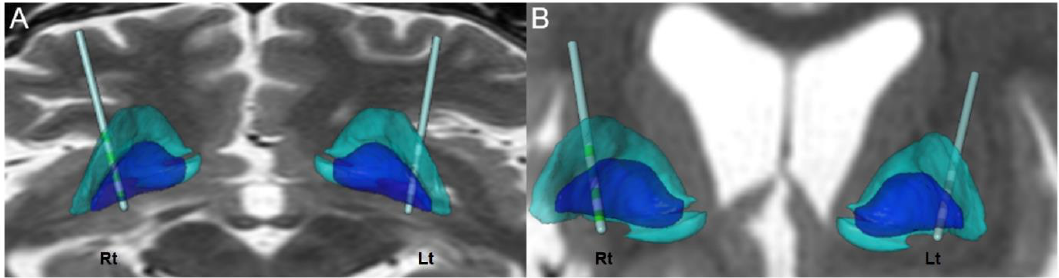
Figure 3. The lead analysis was performed to identify the actual locations of each contact. Blue represents the globus pallidum internus (Gpi) and blue green represents the globus pallidum externus (Gpe). Contact 0 and 1 are located within the Gpi for both electrodes. ( A ) Axial plane ( B ) Coronal plane .